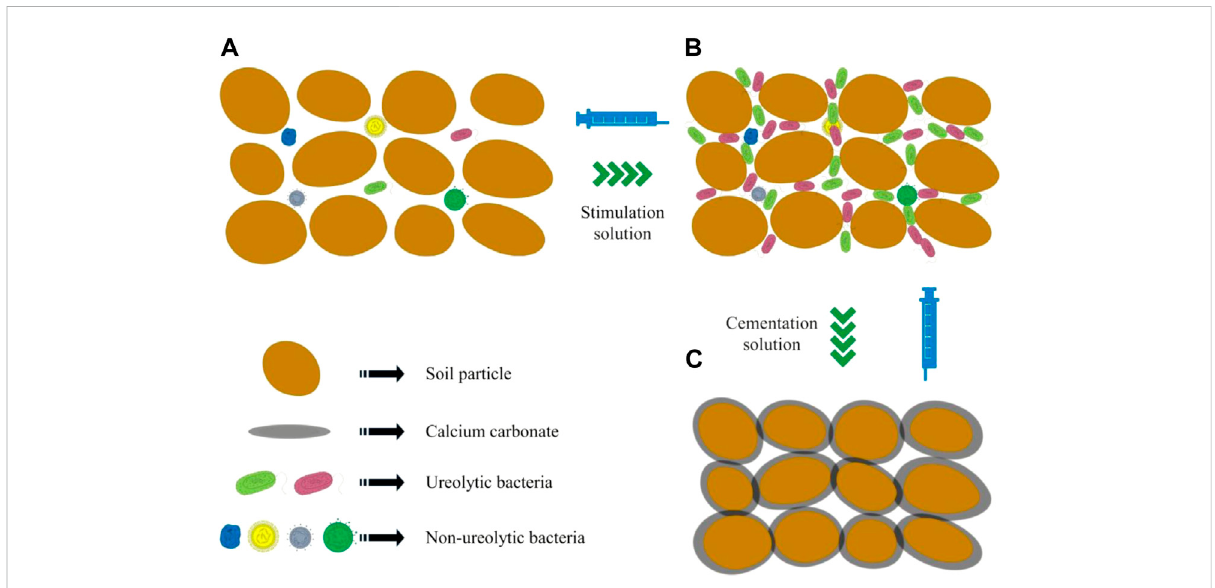
FIGURE 12 Mechanism of soil reinforcement by stimulation of native microorganisms for biomineralization (A) : untreated sample; (B) biostimulated sample; (C) biomineralized